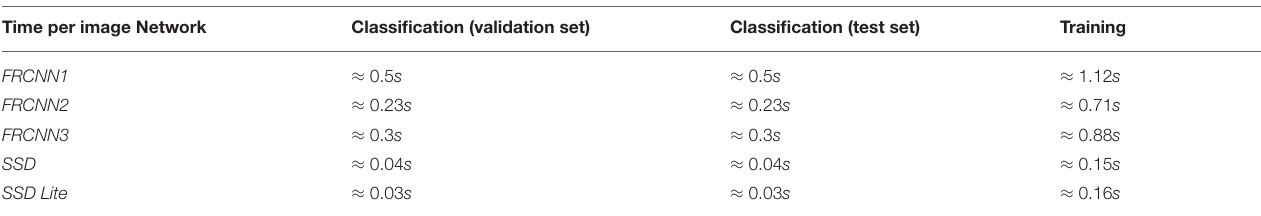
TABLE 2 | Average time required by each network to classify or train on an image. Time per image